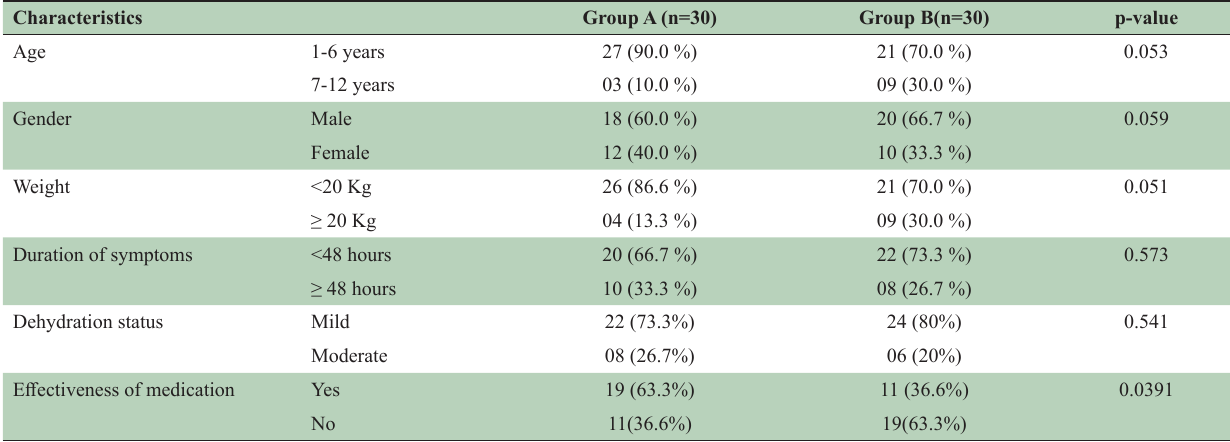
Table-I: Demographics and clinical features of participants.